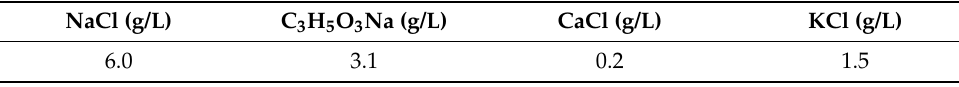
Table 3. Chemical composition of the Ringer’s lactate solution used in EIS